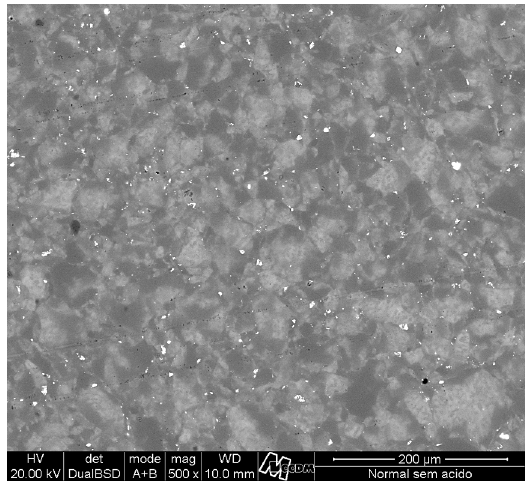
Figure 3. SEM images at 500 x magnification of Vita VM9 submitted to normal cooling.